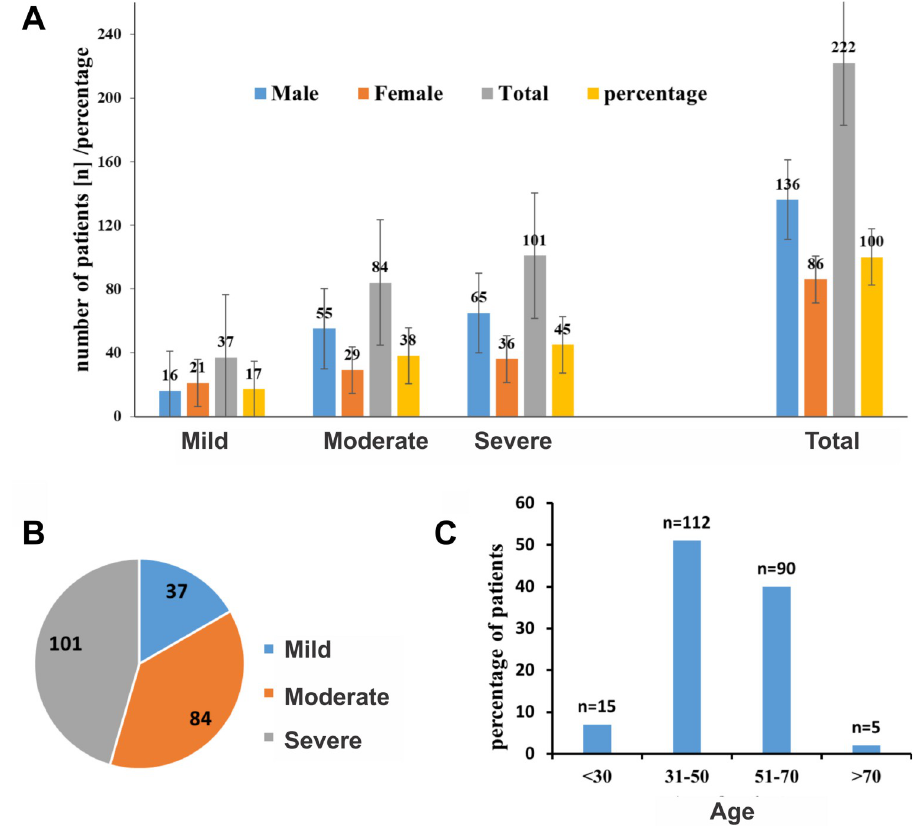
Fig 1. A: Distribution of chronically HCV infected patients suffering from mild, moderate, or severe cirrhosis. B: Distribution of the HCV infected patients in respect to their cirrhosis stage (mild, moderate, and severe). C: Age distribution of HCV cirrhotic